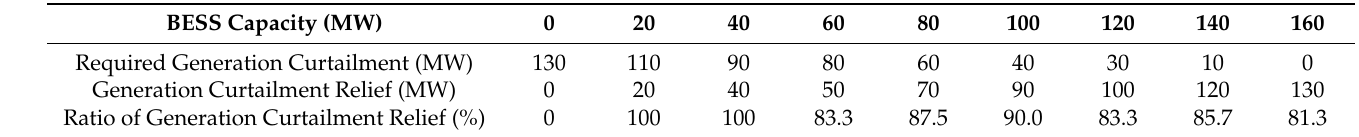
Table 1. Performance of a hybrid control BESS to relieve generation